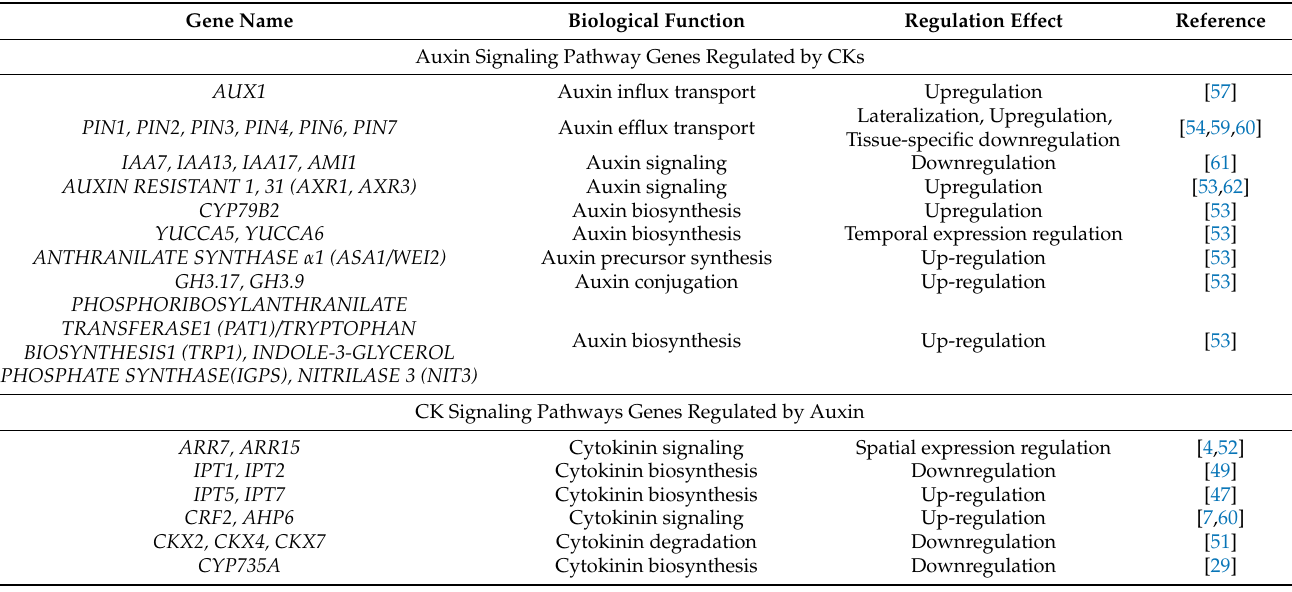
Table 1. Interactions of signaling pathway genes regulated by auxins and